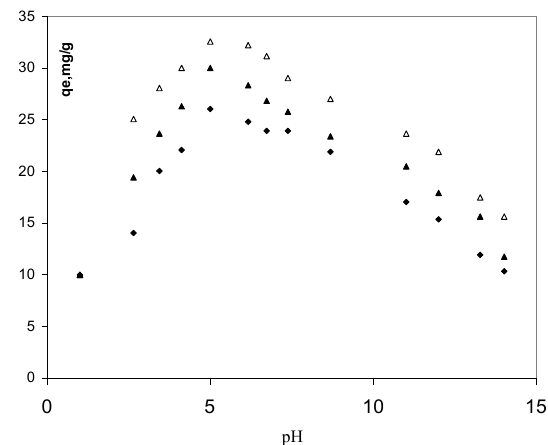
Figure 4 . pH effect on ACOP adsorption of (▲)Cr 3+ , (♦)Cd 2+ , and (Δ)Co 2+ . Conditions: C 25 mg/L; ACOP dose, 0.02 g; contact time, 20 min and temperature, 298